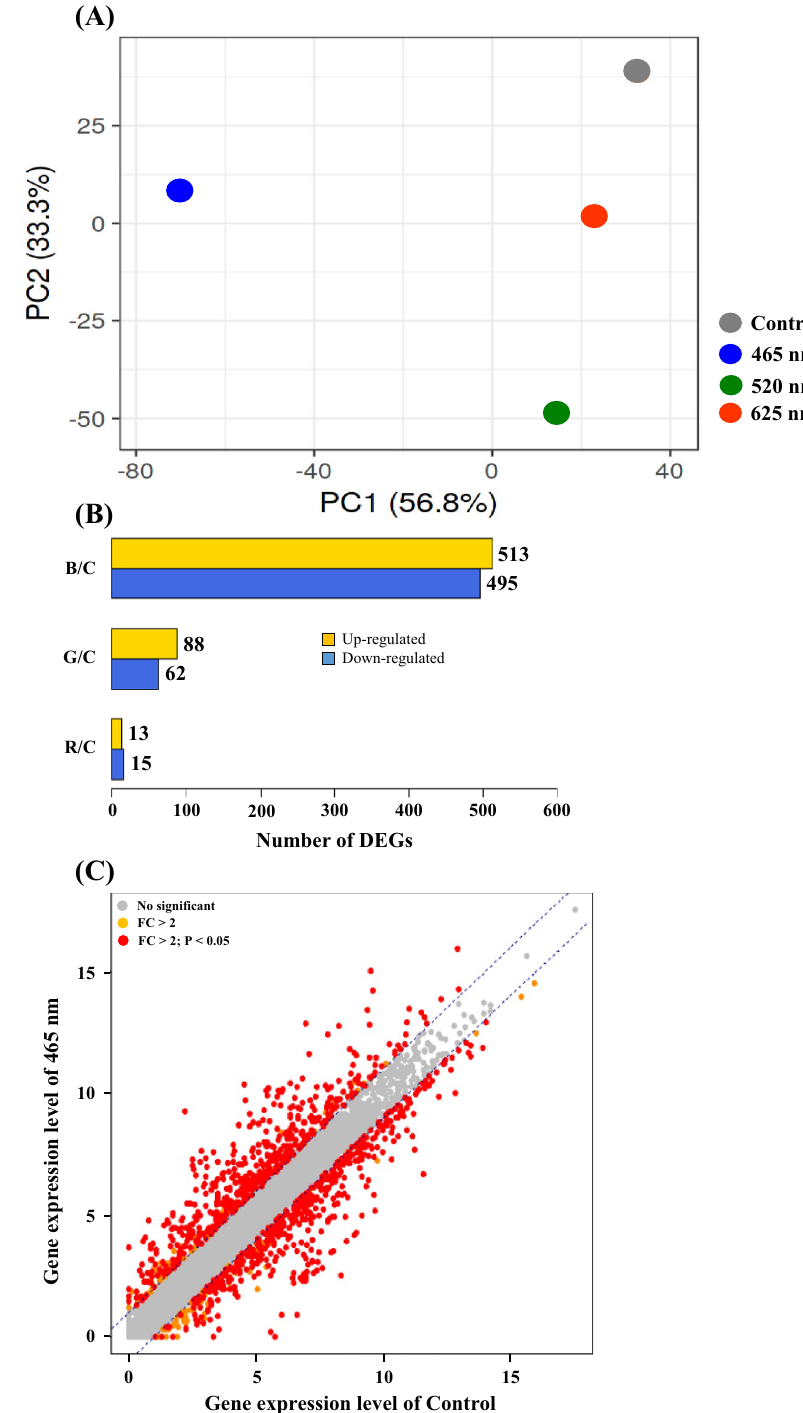
Figure 2. Principal component analysis (PCA) of genes expression of E. coli O157:H7 treated under different wavelength of lights. Cells growth under dark condition was served as control. Unit variance scaling is applied to rows; SVD with imputation is used to calculate principal components. X and Y axis show principal component 1 and principal component 2 that explain 56.8% and 33.3% of the total variance, respectively. N = 4 data points ( A ), Distribution of differentially expressed genes (DEGs). The X-axis is the comparison of different groups (B, 465 nm; G, 520 nm; R, 625 nm; C, control) and the Y-axis is the number of DEGs ( B ) and Scatter plot to show the distribution of DEGs. The gray color represents non-DEGs and genes scattered along X–Y axis indicate the genes which were overabundant under blue 465 nm illuminated light and Control ( C